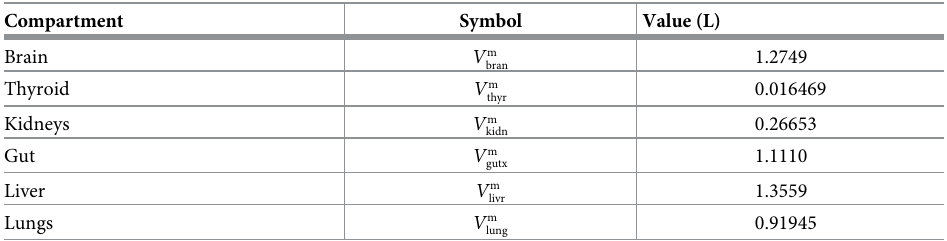
Table 13. Volumes of (some) maternal compartments that do not change during pregnancy.